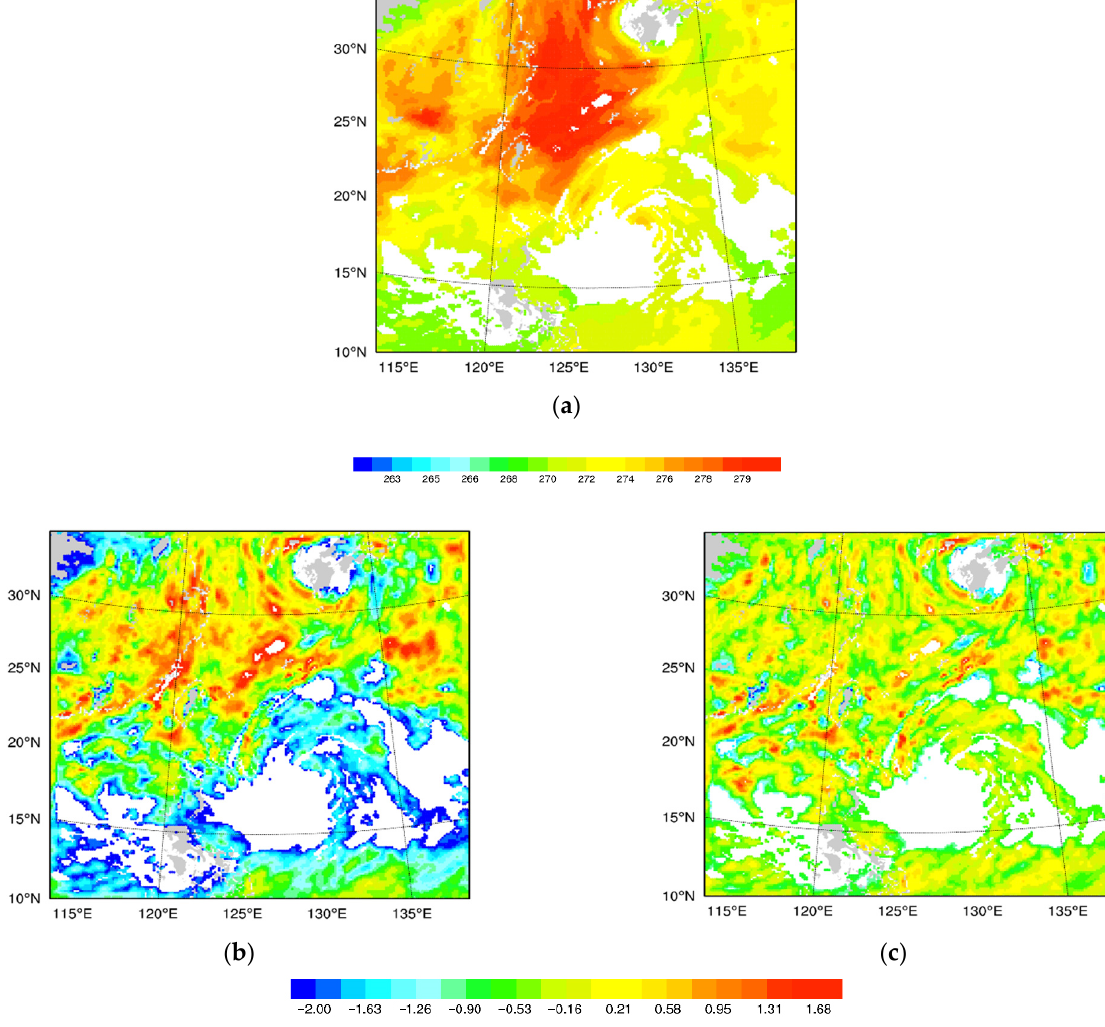
Figure 5. The GEOMS brightness temperature (K): ( a ) simulated observation; ( b ) observation minus background; ( c ) observation minus analysis at 0000 UTC 6 August 2019.